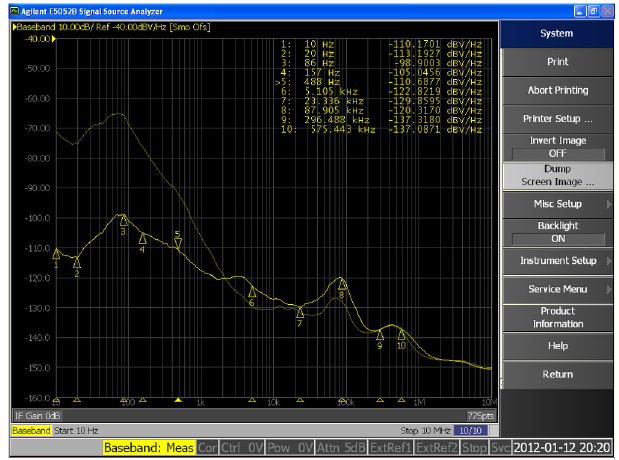
FIG. 36. Signal source analyzer screenshot illustrating the improvement of the jitter of the Nd ∶ YLF laser: Using the in- house built synchronization unit with gain optimized within the controller bandwidth, the laser exhibits a jitter of 45 fs in the spectral range between 10 Hz and 10 MHz (bright yellow curve with arrows). For comparison, the original synchronization box results in a jitter of about 600 fs in the same spectral range (pale yellow